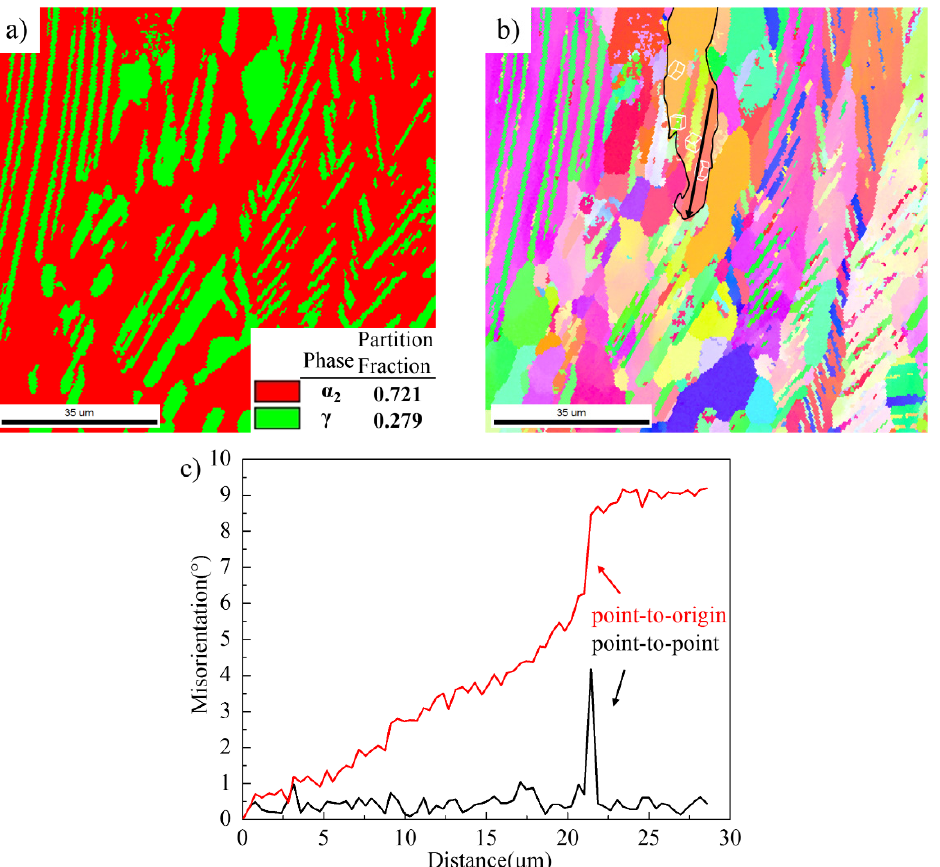
Figure 10. EBSD analysis of the microstructure of water quenched as-rolled Ti-44Al-8Nb-(W, B, Y) alloy with a total rolling reduction of 58% after annealing at 1250 °C for 15 min: ( a ) phase fraction, ( b ) orientation map, and ( c ) misorientation measured along the black line in ( b ).